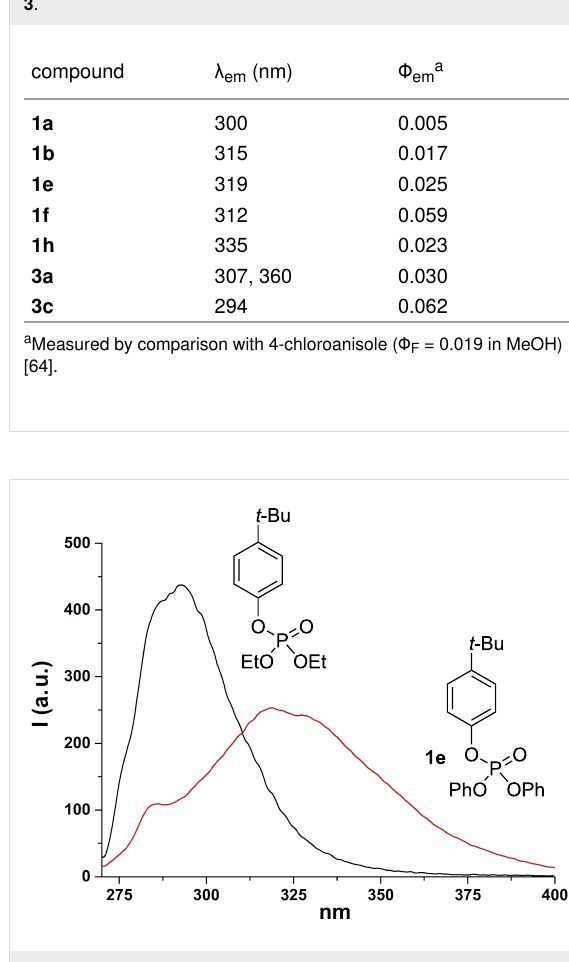
Figure 1: Emission spectrum of compound 1e (red) and of diethyl p - tert -butylphenyl phosphate (black) in methanol.